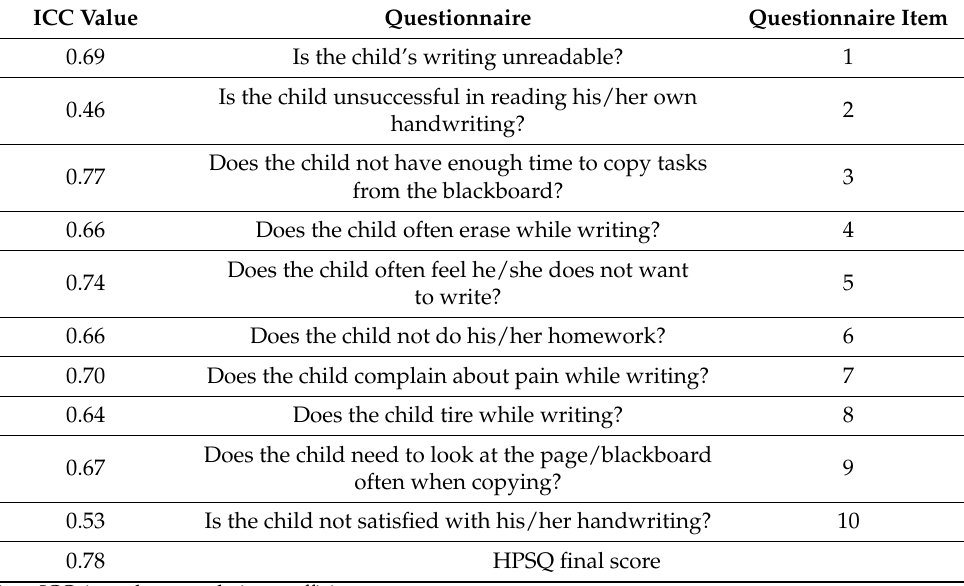
Table 2. Inter-rater ICC agreement values for each item and for the HPSQ-Thai version final score.